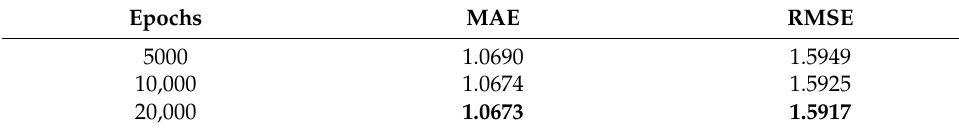
Table 8. Ablation results of the NCF model training with GraphSAGE features.